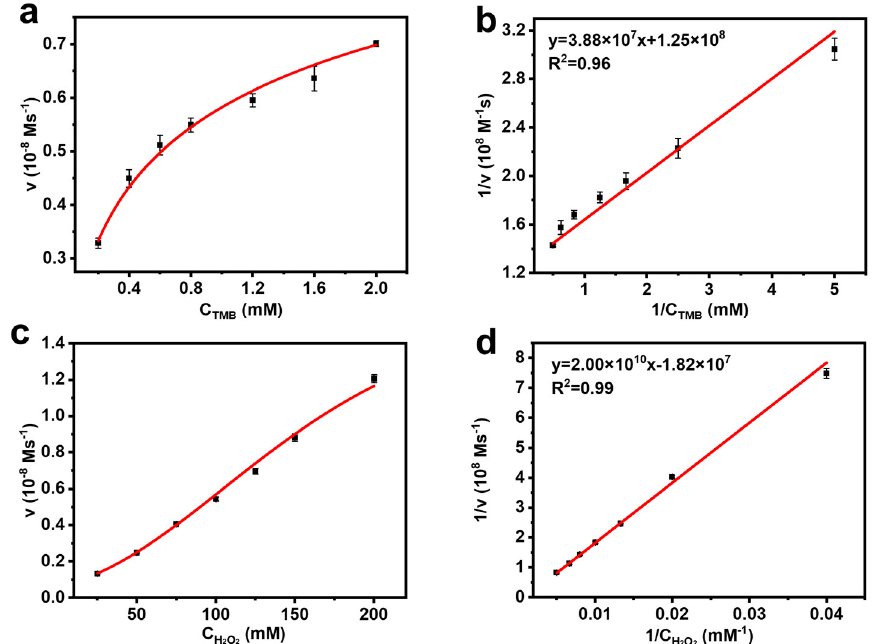
Figure 4. ( a ) The absorption peak at 652 nm in the presence of different concentrations of TMB (0.2, 0.4, 0.6, 0.8, 1.2, 1.6 and 2.0 mM). ( b ) The absorption peak at 652 nm in the presence of different concentrations of H 2 O 2 (25, 50, 75, 100, 125, 150 and 200 mM). PGN concentration was fixed at 100 µM.